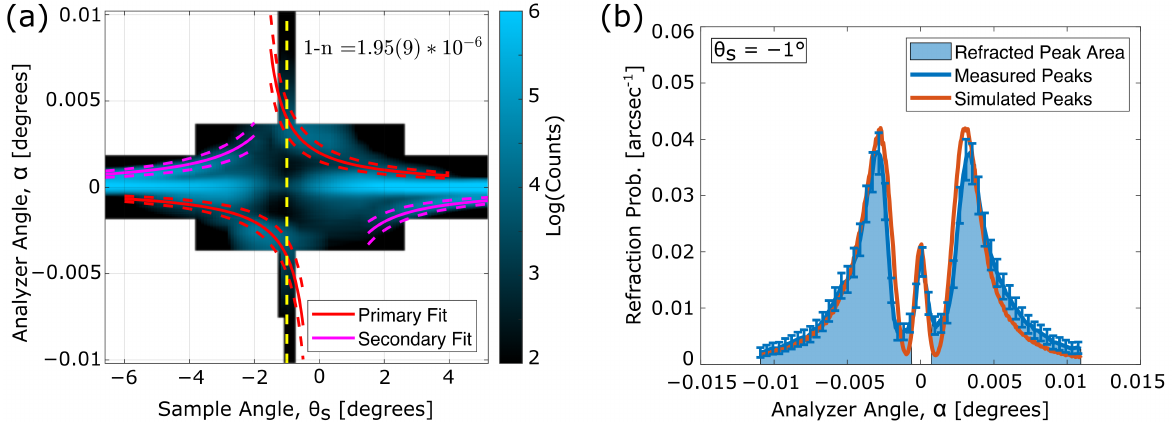
Figure 4. ( a ) Ultra-small-angle neutron-scattering (USANS) results from the TARP where a false colour corresponds to the logarithm of counts. Scattering peaks have been fit to a Gaussian to extract the peak maximum. Red and pink lines correspond to first- and second-order theoretical scattering curves, respectively, fit to these peaks. Curves are calculated via Equations (1) to (4), accounting for the BT-5 wavelength distribution, and fit with a free-fit parameter for material index. Dashed lines show the 95% confidence interval of this fit. This fit returns a material index of n = 1 − ( 1.95 ± 0.09 ) · 10 − 6 . The dashed yellow line indicates a sample angle of θ s = − 1 ◦ . ( b ) Comparison of the TARP USANS measurements (blue) with Monte Carlo simulation (red) taken at θ = − 1 ◦ . The shaded area in blue denotes the region where beam deviation is expected from the simulation of an ideal TARP, with perfect apices. Uncertainty on neutron counts is shown for a subset of analyzer measurement angles. Neutron ray deviations from USANS experiments with the TARP show qualitative agreement with